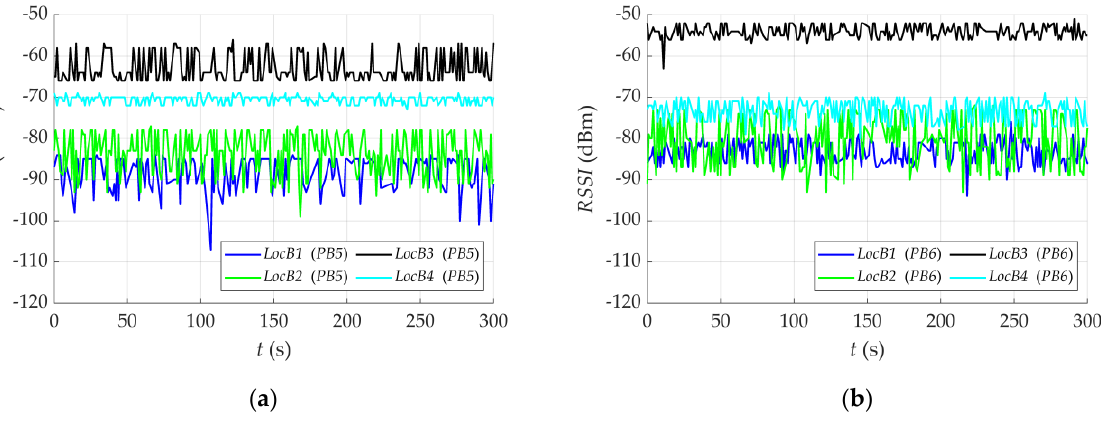
Figure 12. Measurements of RSSI values obtained by four locator nodes for an object placed 1.8 m from the receiver: ( a ) LocB3 (location PB3 ); ( b ) LocB4 (location PB4 ).